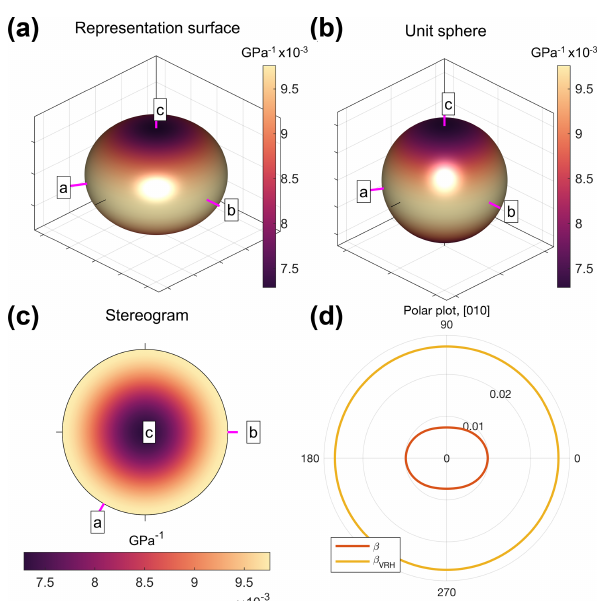
Figure 7. Alternative visualisations of the anisotropy of linear com- pressibility ( β , in GPa − 1 ) of α -quartz. (a) 3D representation surface where the radius in any direction is proportional to the magnitude of β . (b) Projection of β on to a unit sphere, colour-coded by mag- nitude. (c) Lower-hemisphere equal-area stereographic projection. (d) Polar plot of anisotropy of β in the (010) plane. Crystallographic axes (cid:104) a (cid:105) , (cid:104) b (cid:105) and (cid:104) c (cid:105) shown in pink. VRH represents the Voigt– Reuss–Hill average value of β